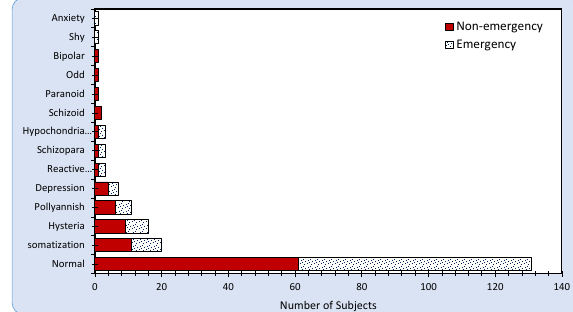
Figure 1. Distribution of the frequency of personality disorders in the studied population based on the department they worked